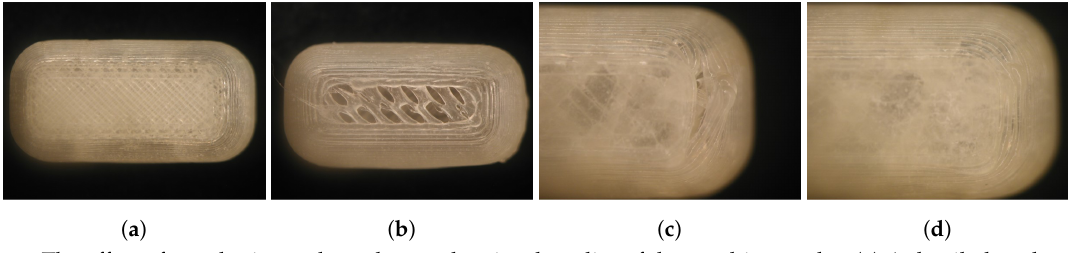
Figure 10. The effect of nozzle size and overlap on the visual quality of the resulting caplet. ( a ) A detailed caplet printed using a nozzle of 0.25 mm; ( b ) a caplet printed using a nozzle of 0.60 mm showing a less detailed surface; ( c ) a caplet (cid:31) (cid:31) produced with an overlap of 10% with visual deformation between infill and shells; and ( d ) a caplet printed with an overlap of 50%. Table 6. The effect of caplet size (as constructed in the .stl file) on the final caplet characteristics for the EPO:PEO:ZHT (69.3:29.7:1) blend printed with a 0.25 mm (cid:31)